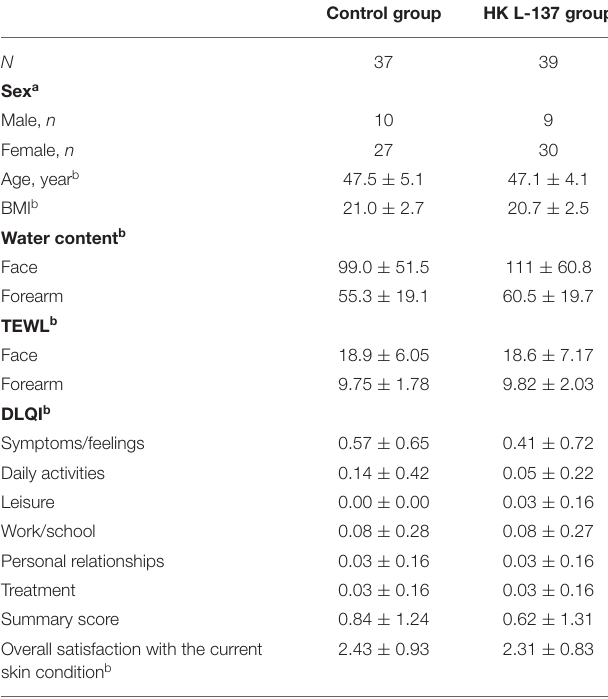
TABLE 1 | Baseline participant